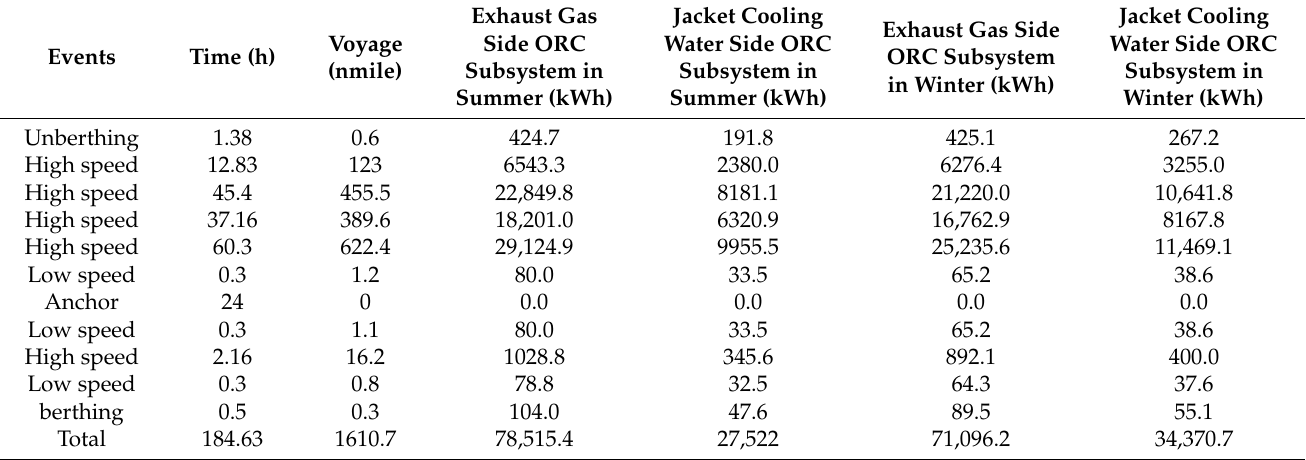
Table 12. Total work or amount of energy saving produced by the ORC system when adopting low-sulfur fuel oil.